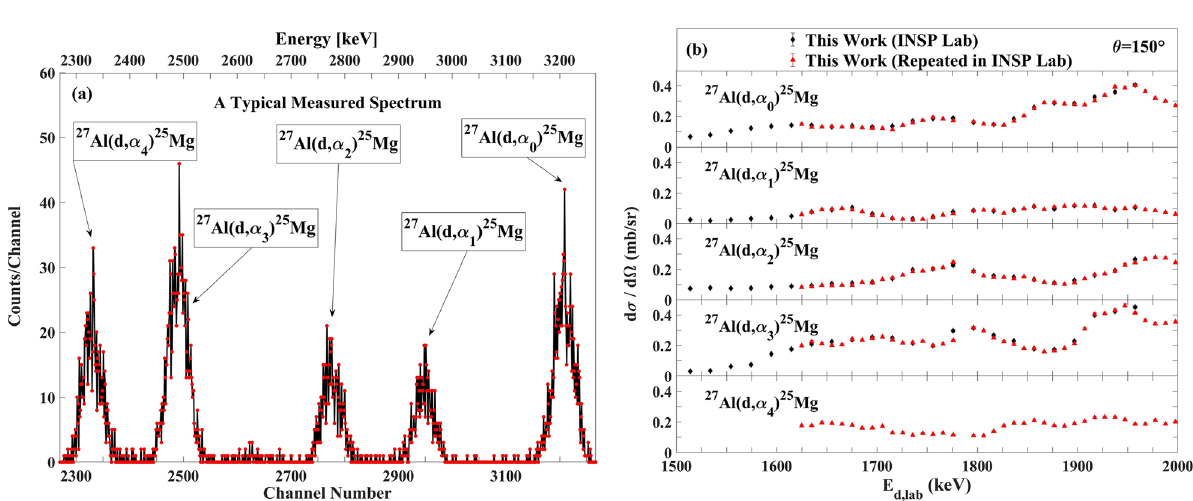
Figure 8. ( a ) A typical spectrum of a-particles for the 27 Al(d,α) 25 Mg reaction, ( b )The excitation functions for the 27 Al(d,α) 25 Mg reaction at scattering angle 150° at INSP Lab in Paris. The estimated uncertainties from counting statistics are smaller than the plotted